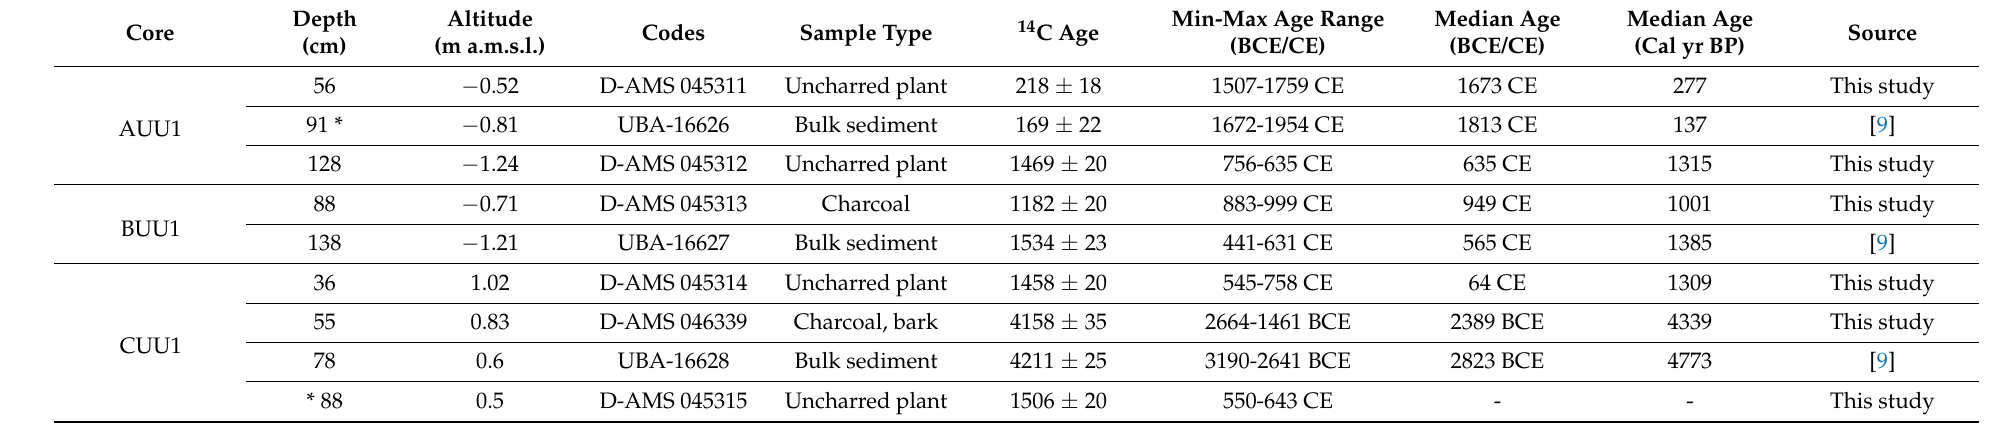
Table 1. Radiocarbon ages from Unguja Ukuu mangrove areas including calibrated ages using the Southern Hemisphere calibration of the SHcal20 curve [63]. Asterisk (*) refers to excluded dates. (a.m.s.l. refers to above mean sea